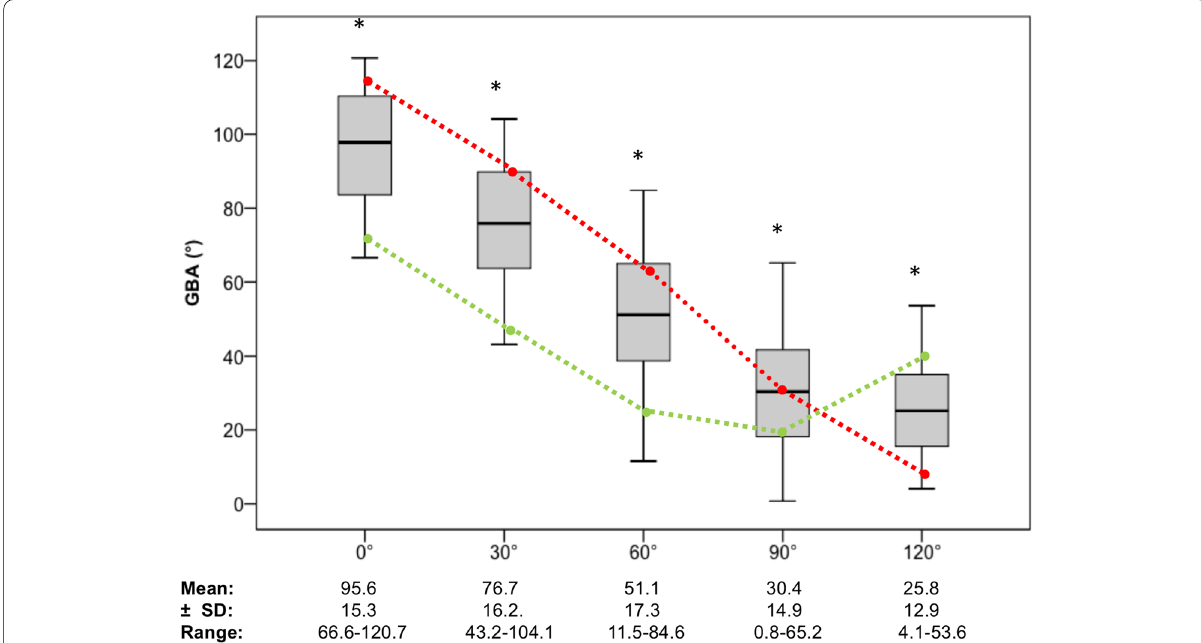
Fig. 5 Mean graft bending angle (GBA) for all subjects and FTE among flexion grades. GBA: Graft bending angle. SD: Standard deviation. Boxplots depicts mean (line), 1st and 3rd quartile (box), minimum and maximum (whisker). Significant differences between groups after Bonferroni correction marked with * (90° vs. 120° p 0.002), remaining: p < 0.001; ANOVA). Red dotted line: FTE with the greatest mean GBA-excursion; = ΔGBA 102.1 6.3° (most distal-anterior FTE). Green dotted line: FTE with the smallest mean GBA-excursion; ΔGBA = ± proximal-posterior